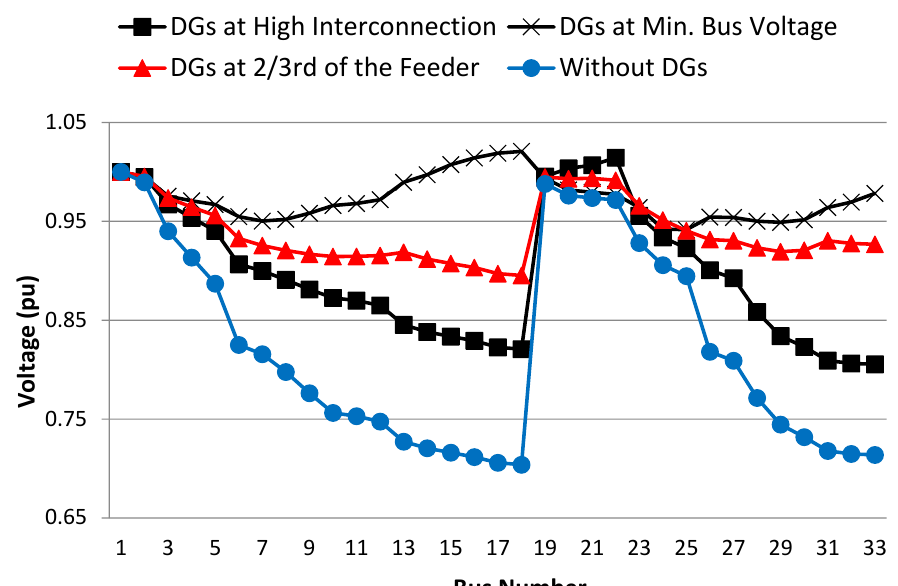
Figure 12. The voltage profile at 250% loading condition.